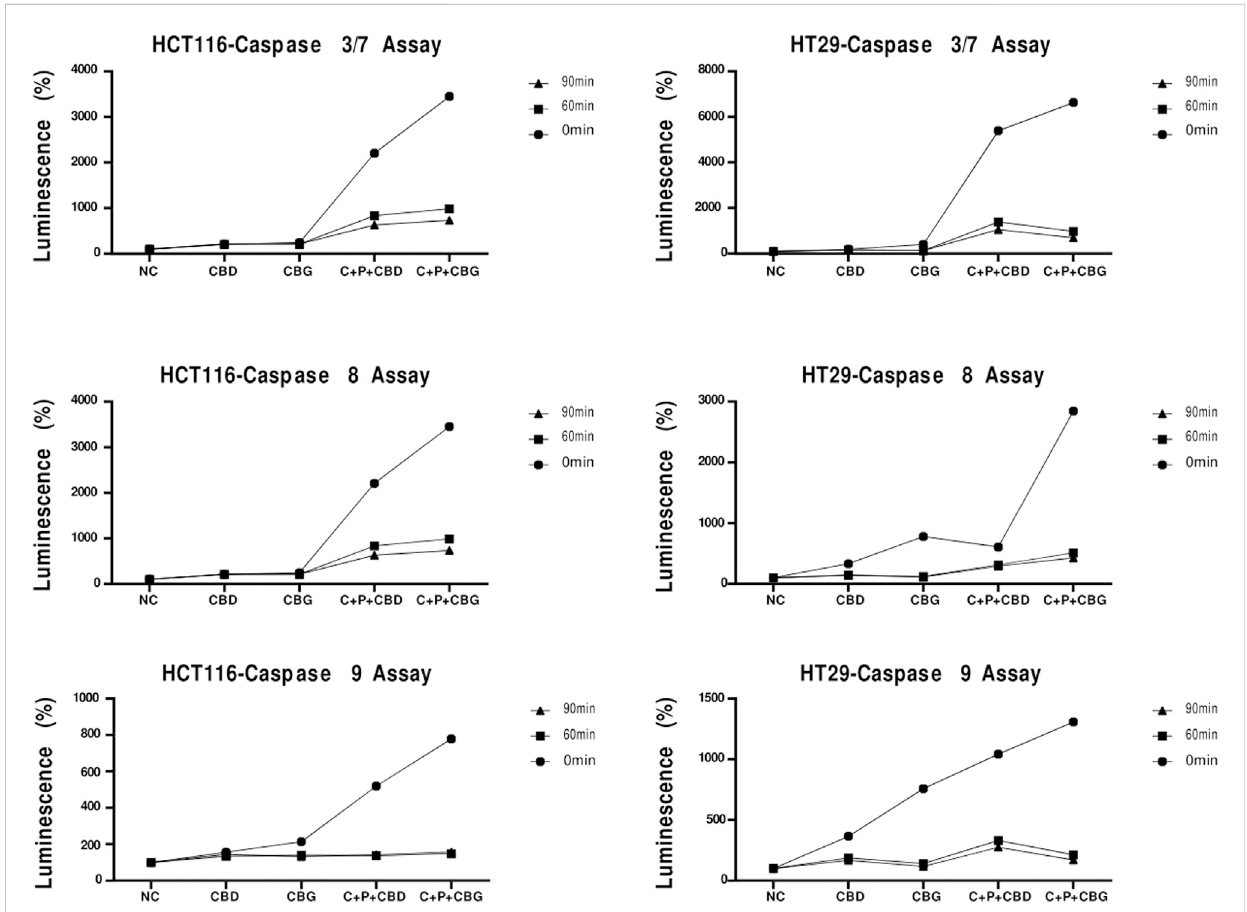
FIGURE 5 Caspase 3/7, Caspase 8 and Caspase 9 activation detected by Casepase-Glo 3/7, Caspase 8, and Caspase 9 luminescence assay for 0 min, 60 min and 90 min in HCT116 and HT29 cells that received the indicated treatments CBD (Cannabigerol), CBG (Cannabigerol), C + P + CBD (Combination of curcumin piperine CBD), C + P + CBG (combination of curcumin piperine CBG) for 72